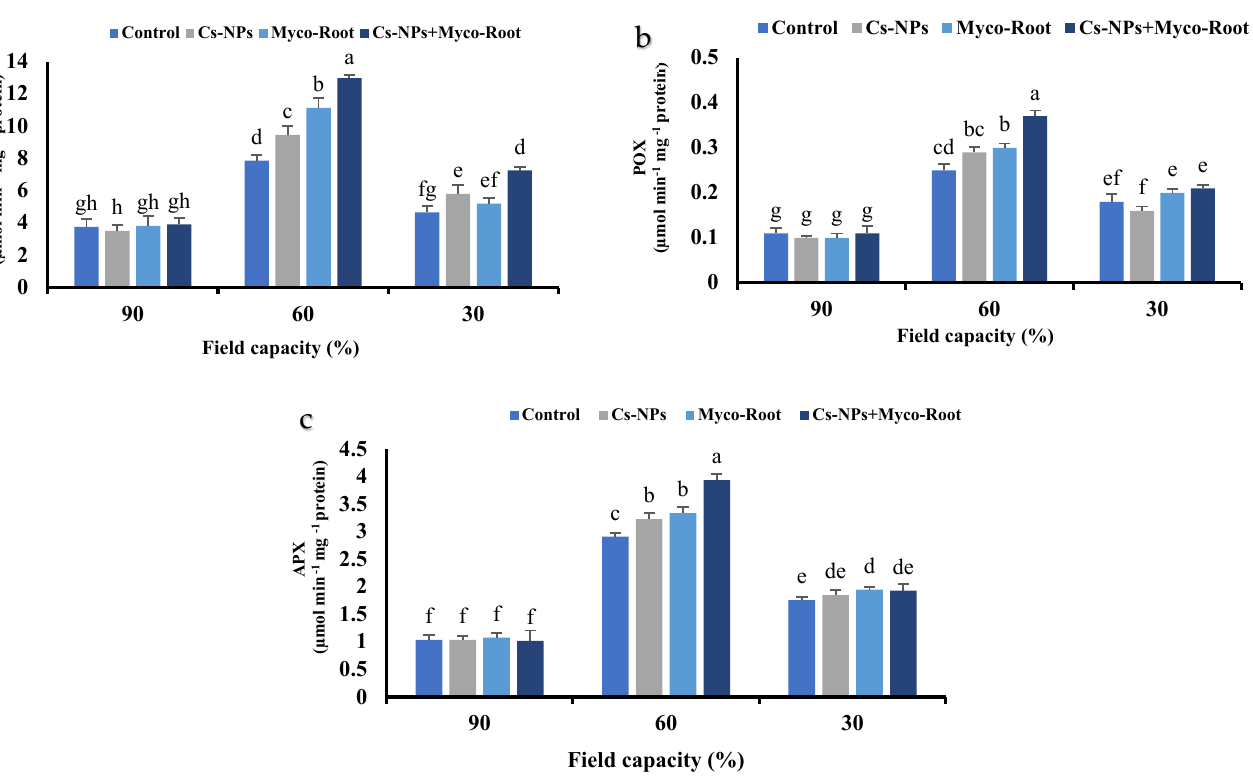
Figure 4. The superoxide dismutase (SOD) ( a ), peroxidase (POX) ( b ) and ascorbate peroxidase ( c ) activity of L. iberica with different fertilizer sources and irrigation levels. Different letters indicate significant differences at the 5% level according to LSD test.